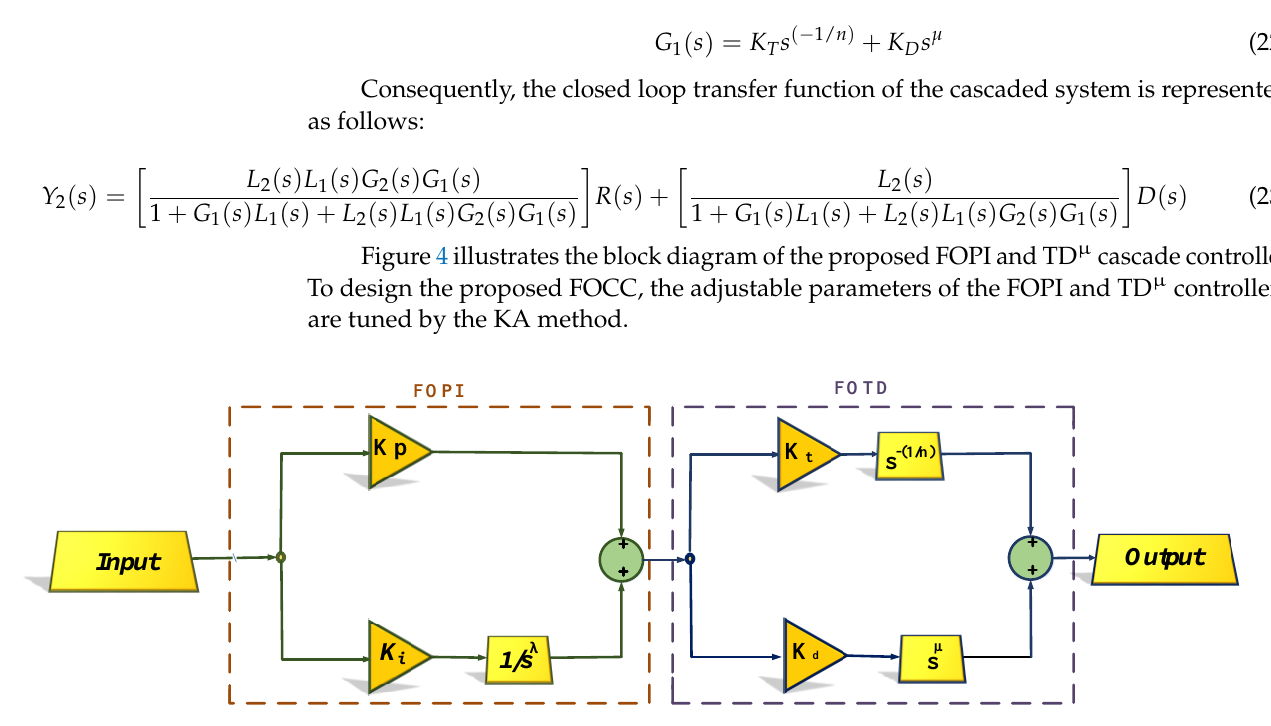
Figure 4. Diagram block of the proposed controller.